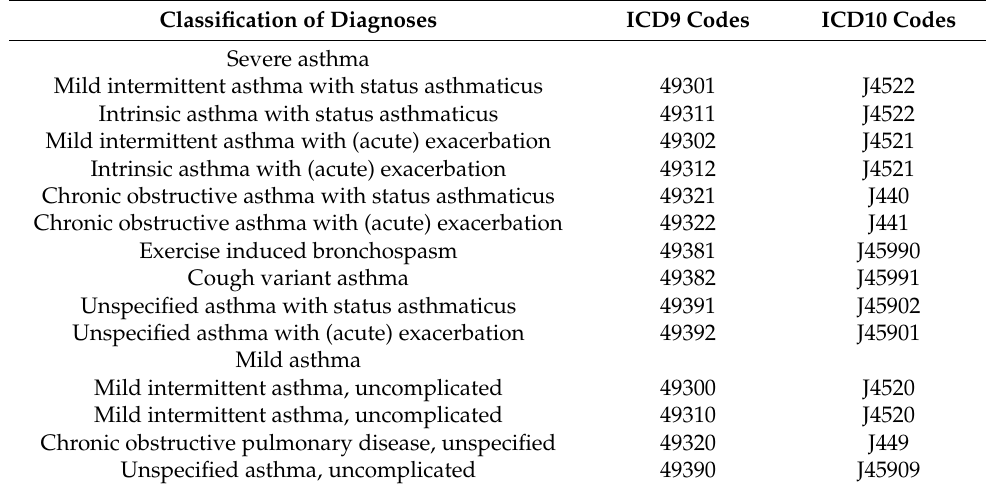
Table A1. Definitions of “severe asthma” and “mild asthma” in this